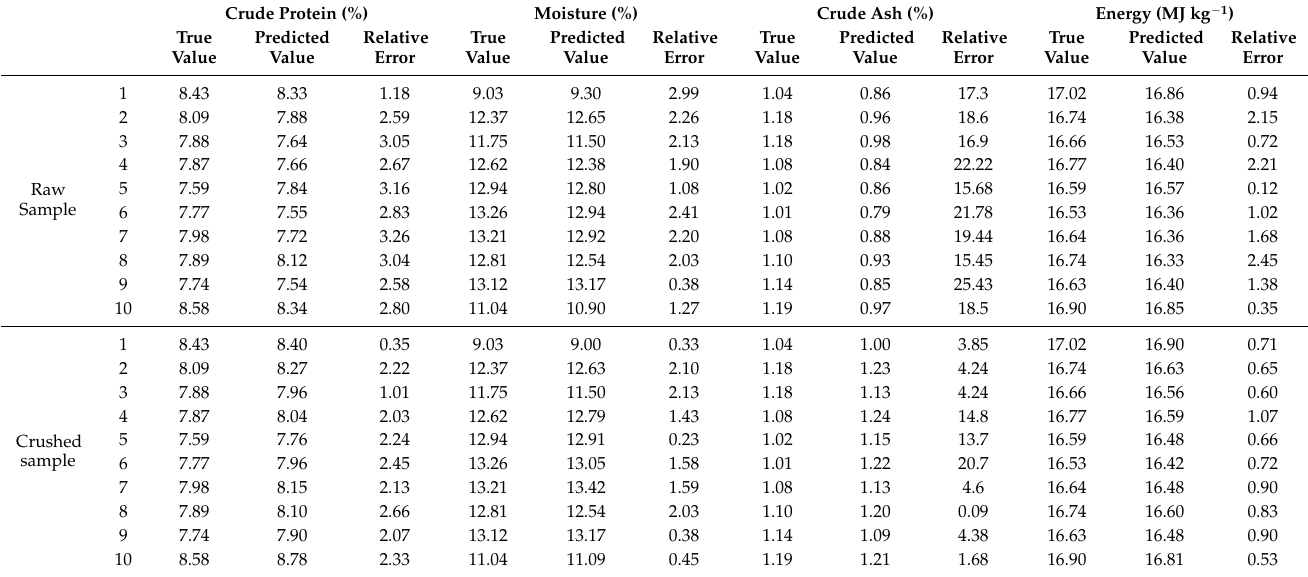
Table 2. Comparison of experimental values and NIR predictions of raw and crushed forage maize